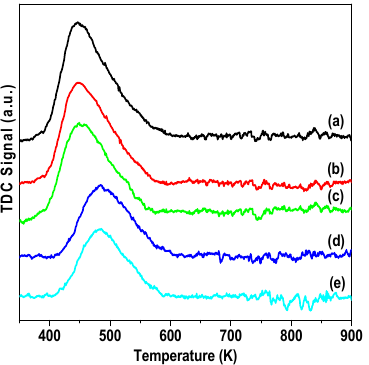
Figure 5. NH 3 -TPD curves of ( a ) NM-ZSM-5-0 h, ( b ) NM-ZSM-5-4 h, ( c ) NM-ZSM-5-8 h, ( d ) NM-ZSM-5-16 h, and ( e ) NM-ZSM-5-24 h.